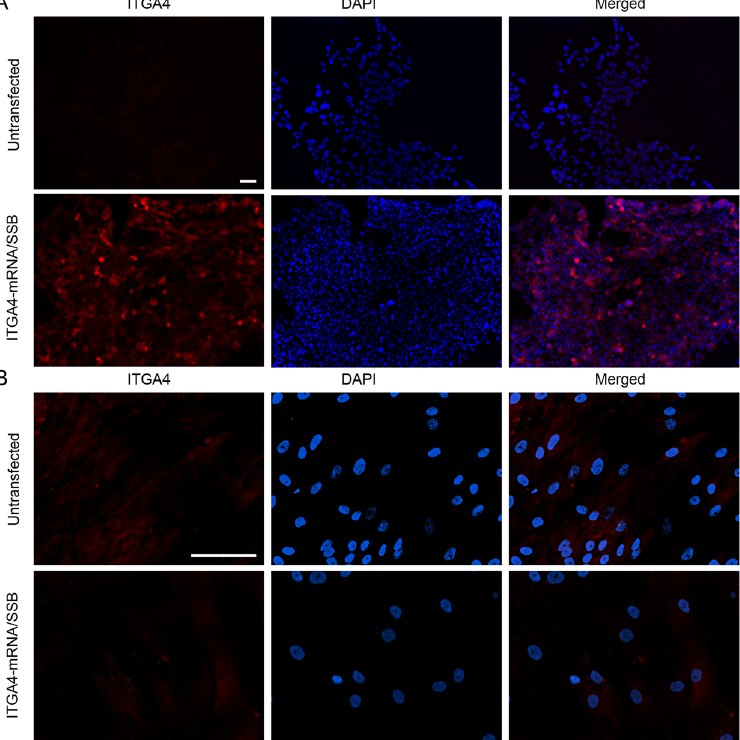
Figure 6. ITGA4 protein synthesis after ITGA4-mRNA/SSB transfection. Immunocytochemistry study for assessment of the ITGA4 protein presence after ITGA4-mRNA/SSB transfection using Lipofectamine ® 2000. Scale bars separate for HEK293 and MSC cells located in the respective left upper images of the panel indicate 100 µ